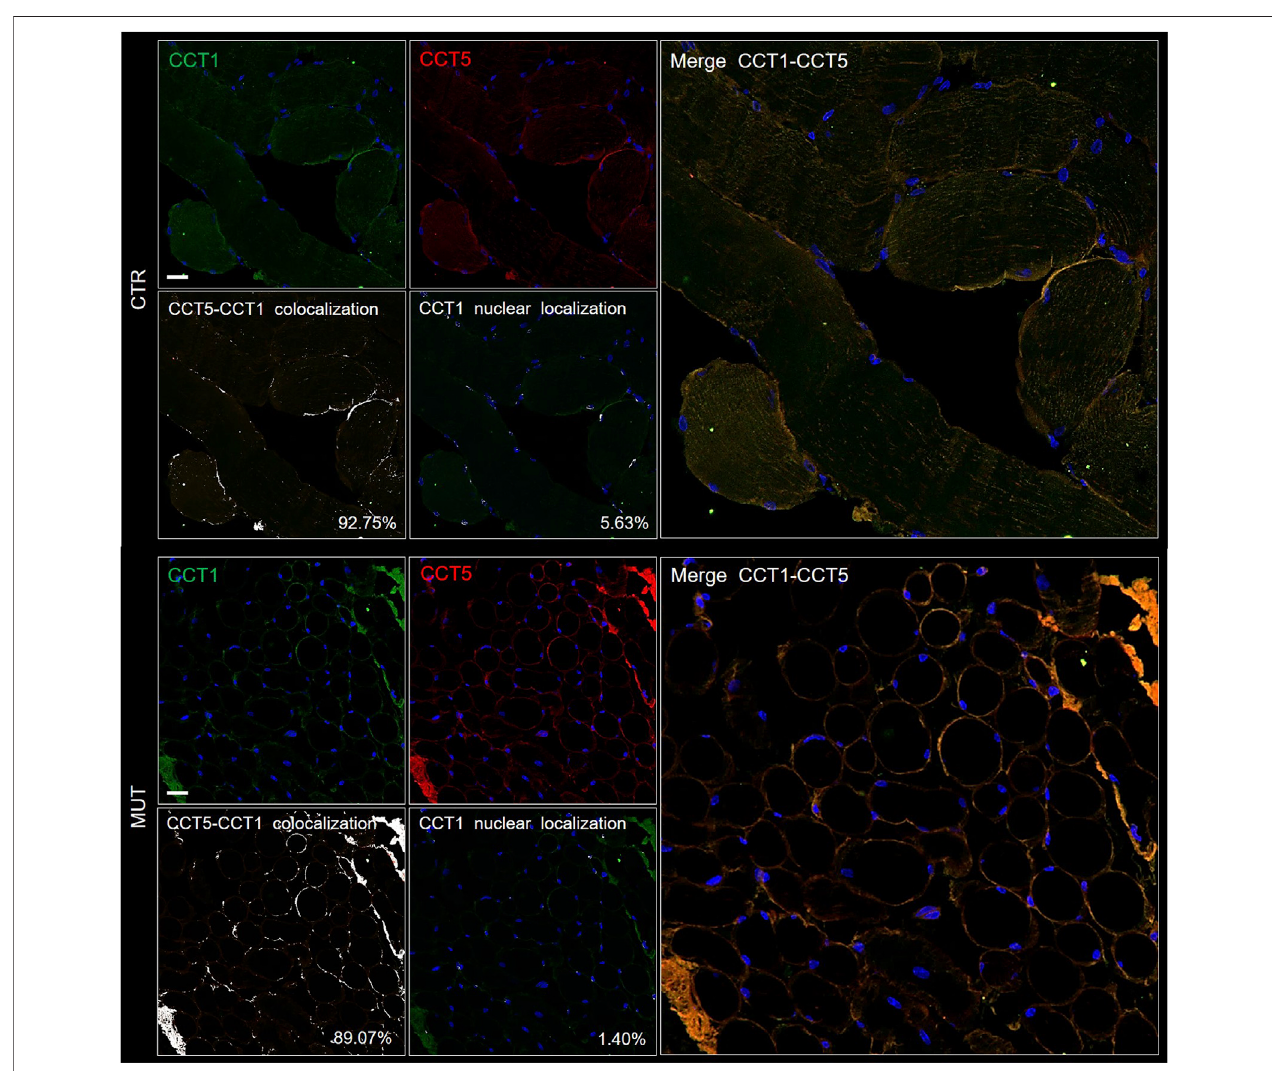
FIGURE4| Double immuno fl uorescence forCCT5 and CCT1 subunits onCTR(top set of fi ve panels) and MUT(bottom set of fi vepanels) muscles.CTRand MUT muscles were stained with FITC conjugated anti-CCT1 antibody (green) and with TRITC conjugated anti-CCT5 antibody (red). Nuclei were stained with probe Hoechst (blue). Colocalization ofCCT5 and CCT1 in CTRmuscle (92.75%) and in MUT (89.07%) muscle appeared aswhitespots (see the twopanels at the bottom left corner of the CTR and MUT sets of panels). Bar = 25 μ m. Nuclear localization of CCT1 in CTR (5.63%) and in MUT (1.40%) muscles appeared as white spots (see the two middle panels at the bottom of the CTR and MUT series of panels with the legend “ CCT1 nuclear colocalization ” ). Bar = 25 μ m.